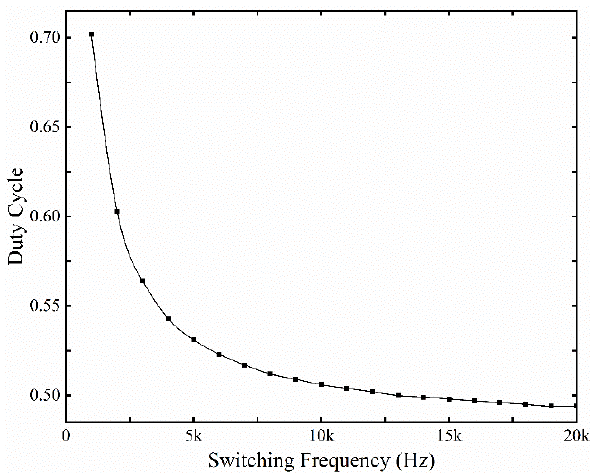
Figure 8. Relationship between duty cycle and switching frequency. Table 1. Values of duty cycle at different switching frequencies.